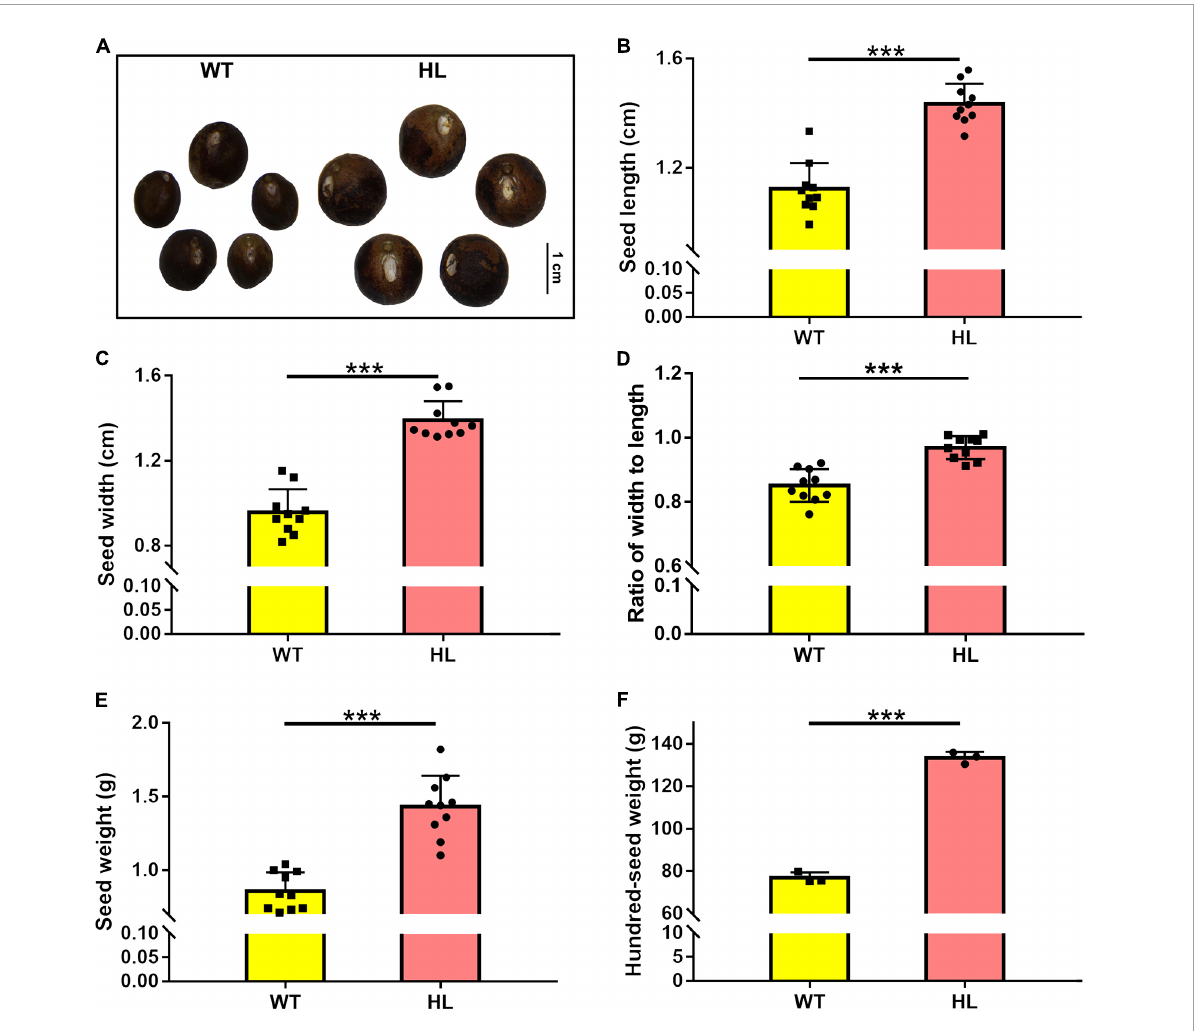
FIGURE1 Seed comparison of North Gordon Euryale (WT) and Hybrid Euryale (HL). After harvest in September (20th week), Phenotype (A) , length (B) , width (C) , ratio of width to length (D) , weight (E) , and hundred-seed weight (F) of fresh seeds of the WT and HL were detected. Bar = 1 cm. Data are mean ± SD. Two-tail Student’s t -test was performed between the WT and HL (* p < 0.05; ** p < 0.01; *** p <